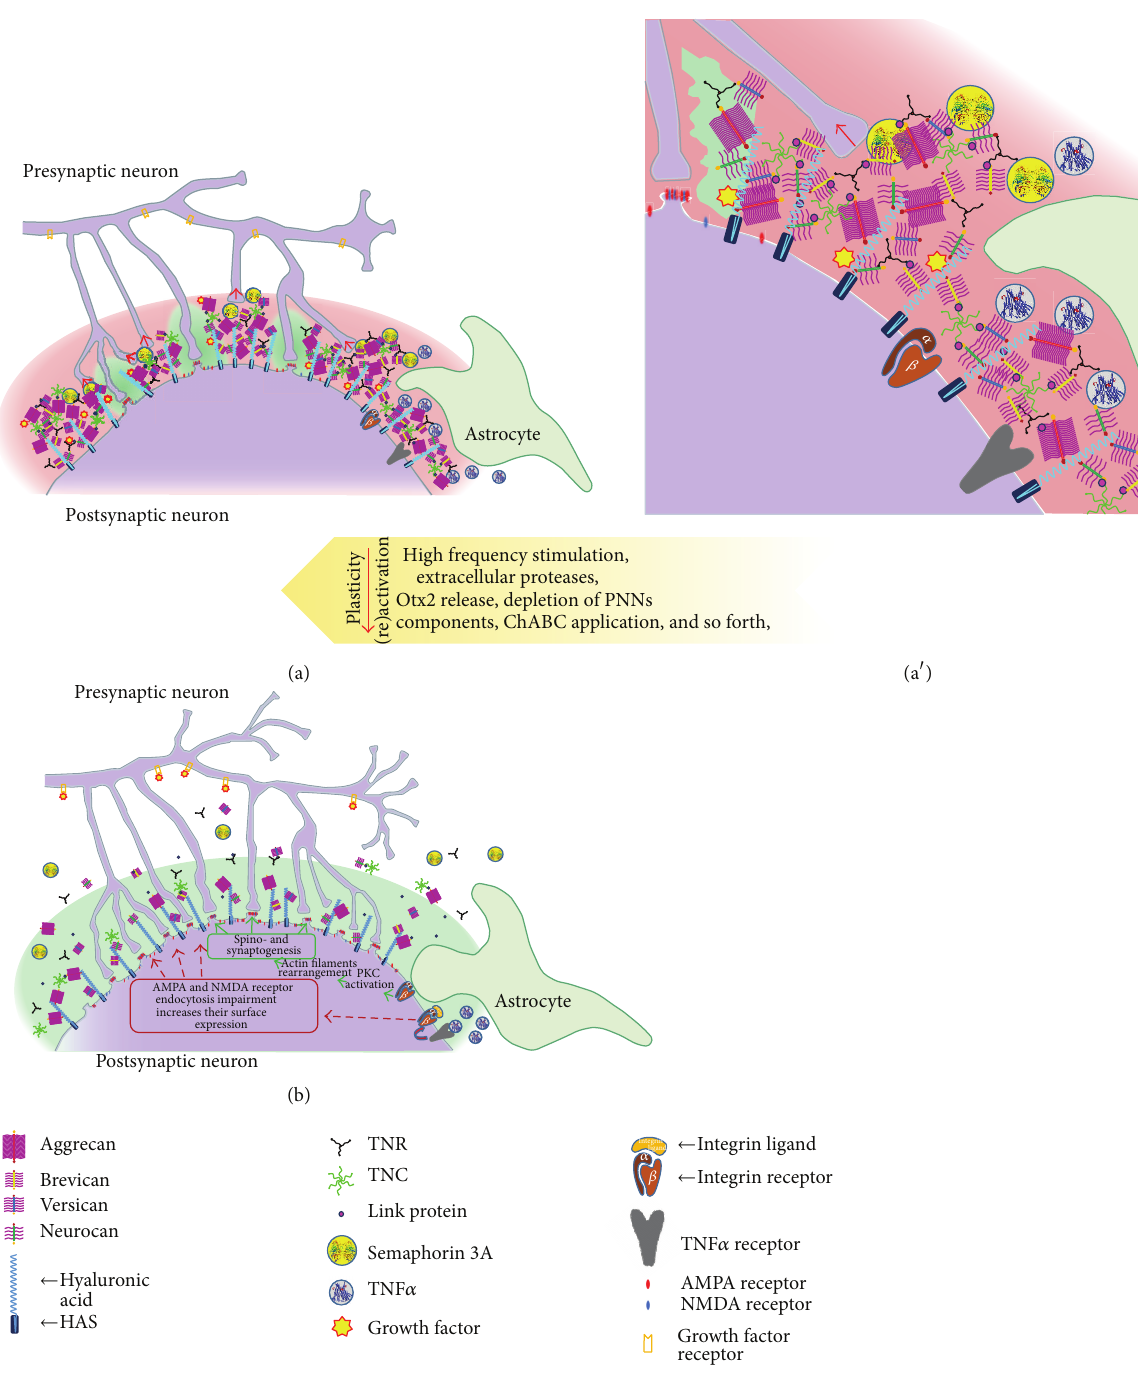
Figure 1: PNNs and neural plasticity. The cartoon depicts the composition of an ECM coat in a PNN on neuronal surfaces, as produced jointly by neurons and astrocytes (a), magnified in (a 󸀠 ). PNNs restrict adult neuronal plasticity, by providing inhibitory environment (depicted in red) restricting astrocyte-induced plasticity and by embedding repulsive guidance molecules. Only several permissive areas are left, indicated in green. Remodelling of PNNs and consequent regain of plasticity (b) can be induced by distinct treatments, as shown by the